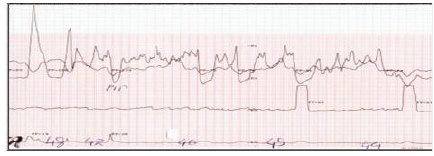
Figure 1: Manometry.